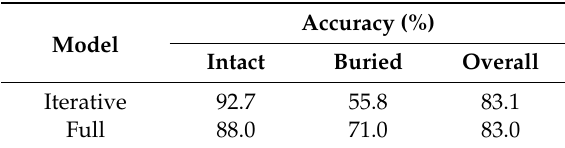
Table 2. Accuracy values for iterative and full burial